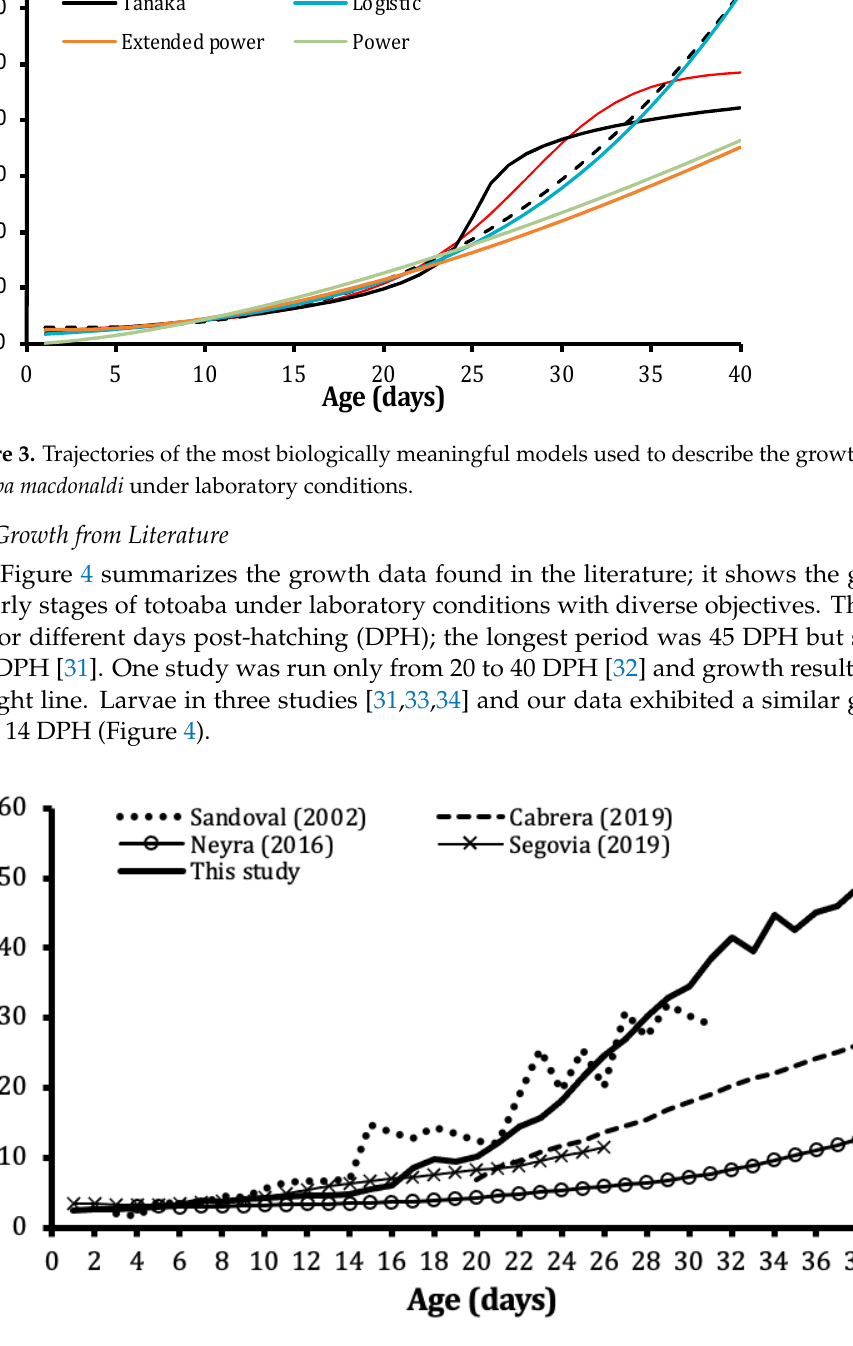
Figure 4. Growth of Totoaba macdonaldi early stages under laboratory conditions reported in different studies. Dotted line: [31]; line and circles: [29]; solid line: this study; broken line: [30]; line and squares: [32].